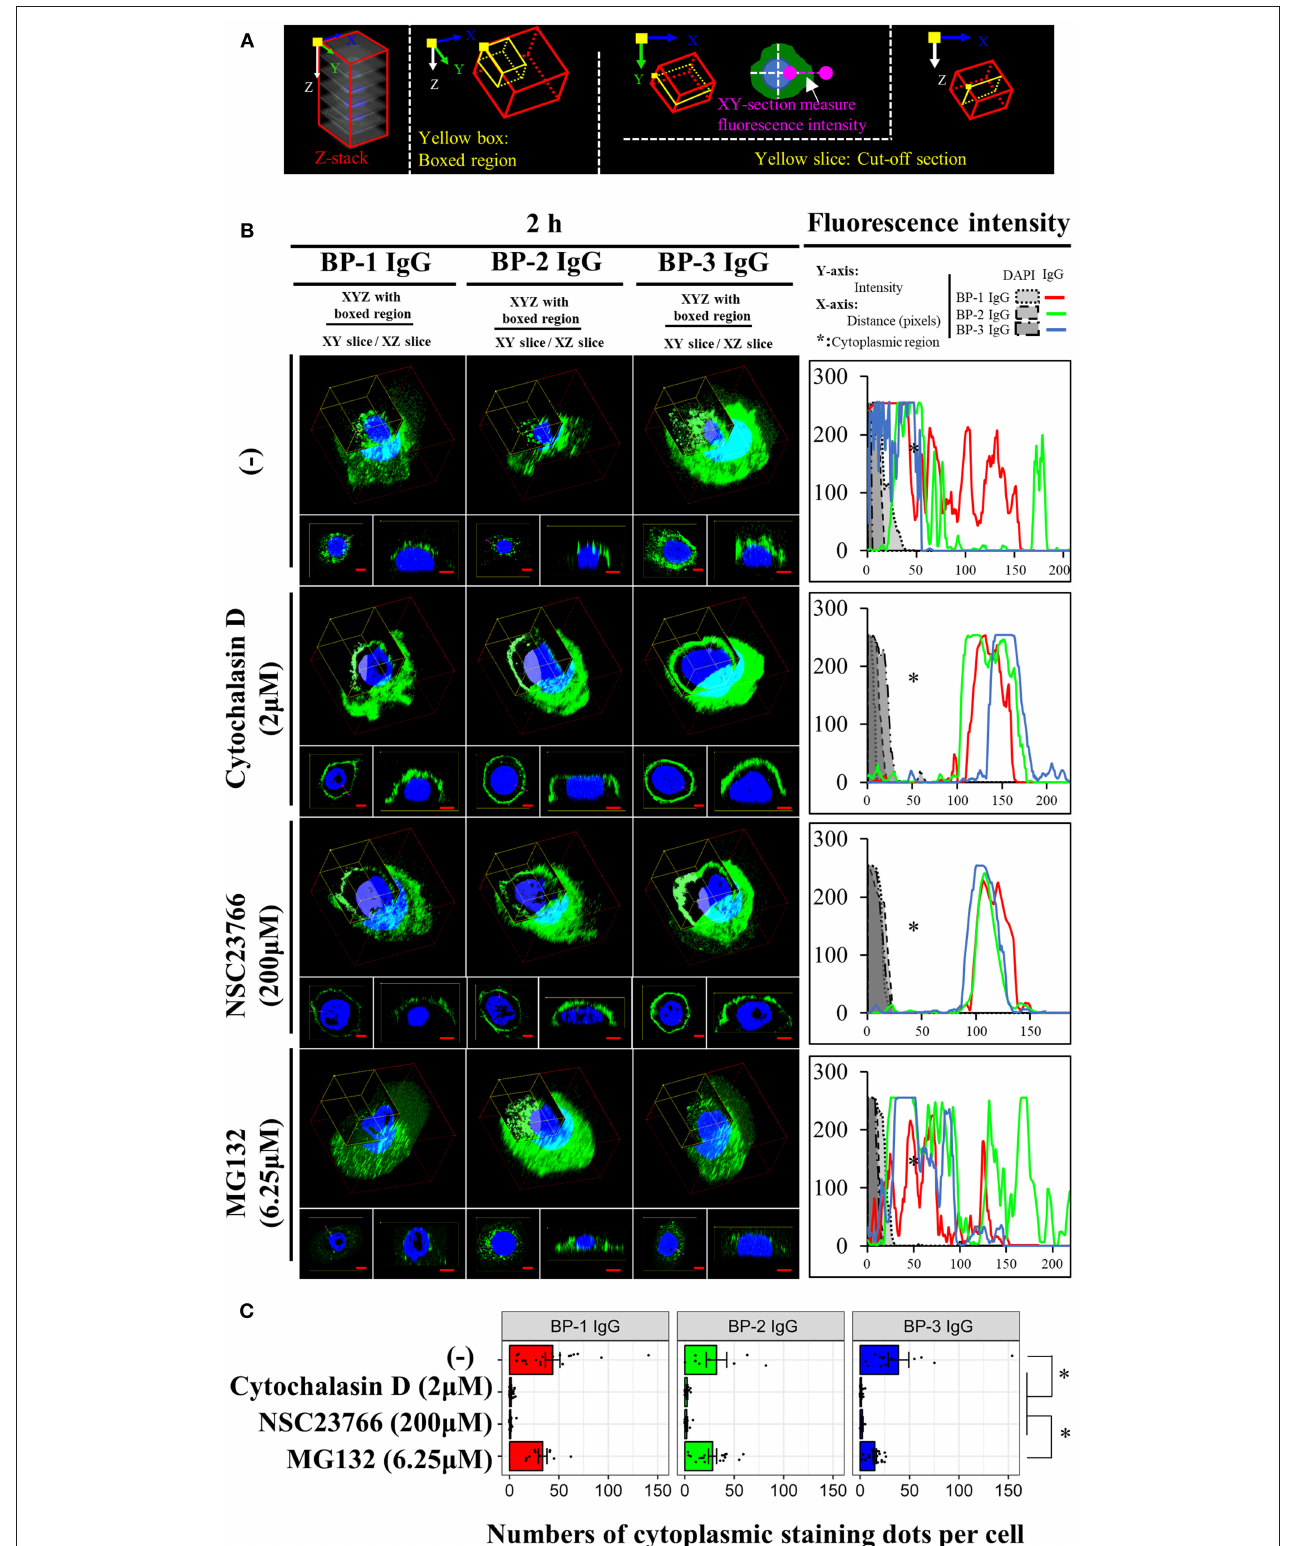
FIGURE 9 | Effects of cytochalasin D, NSC237766, and MG132 on the BP IgG-induced internalization. (A) Overview of the 3D reconstruction assay. The 3D reconstruction was performed as described in the methods. The boxed region indicates XYZ boxed area, XY slice indicates the horizontal slice and used to